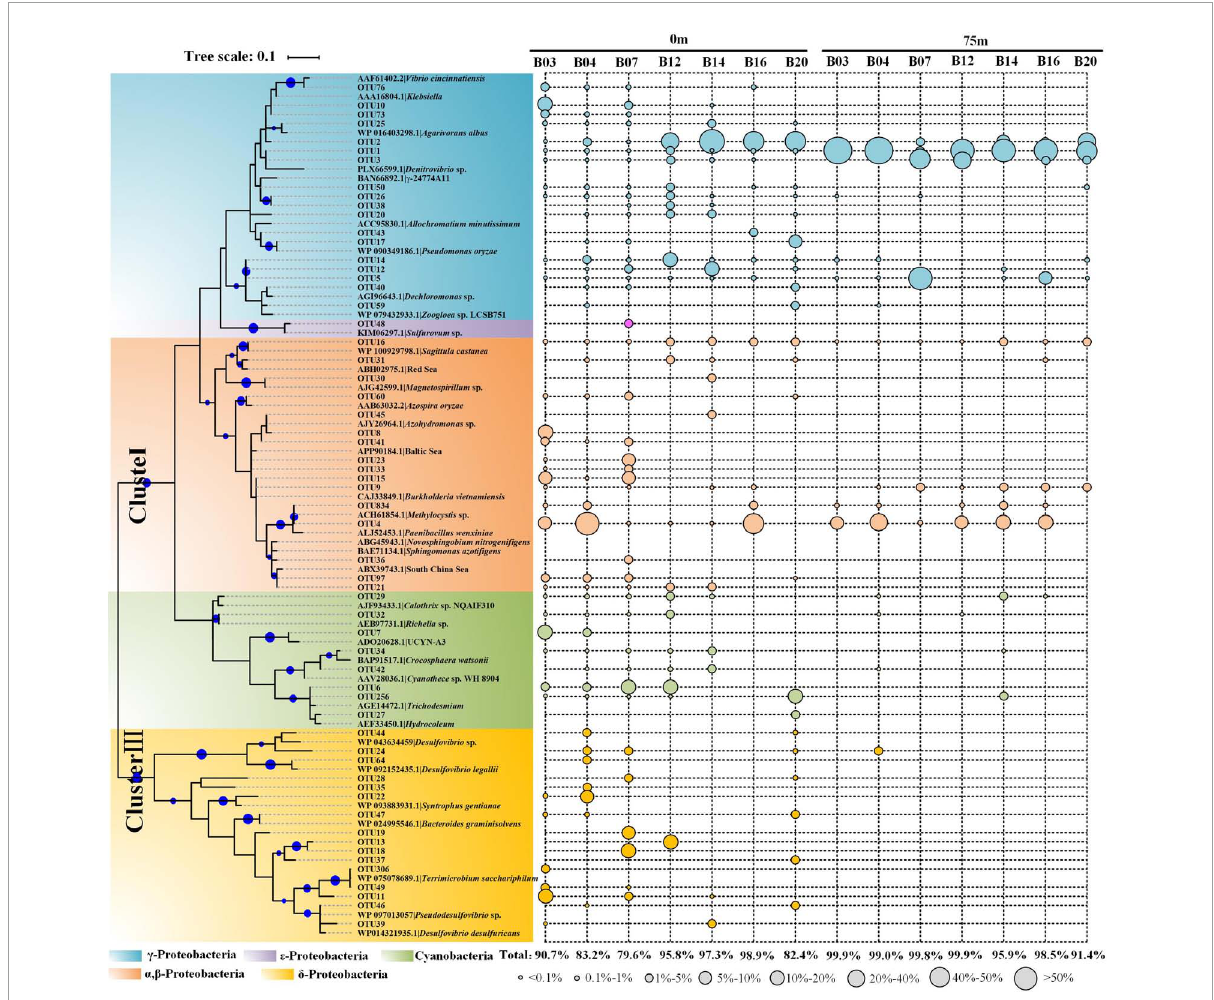
FIGURE4 Neighbor-joining phylogenetic tree constructed by top 59 nif H gene amino acid sequences obtained from the BoB and reference sequences selected from the protein sequences database in GenBank. The topology of the tree was inferred from 1,000 bootstrap resampling, and bootstrap values greater than 50% were labeled with blue circle symbols on the branches. The circle symbols with different sizes represented the relative abundance of each